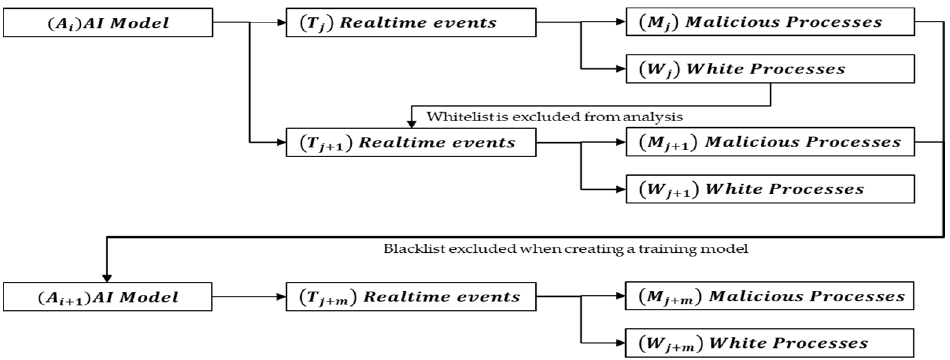
Figure 9. Real-time operation policy.